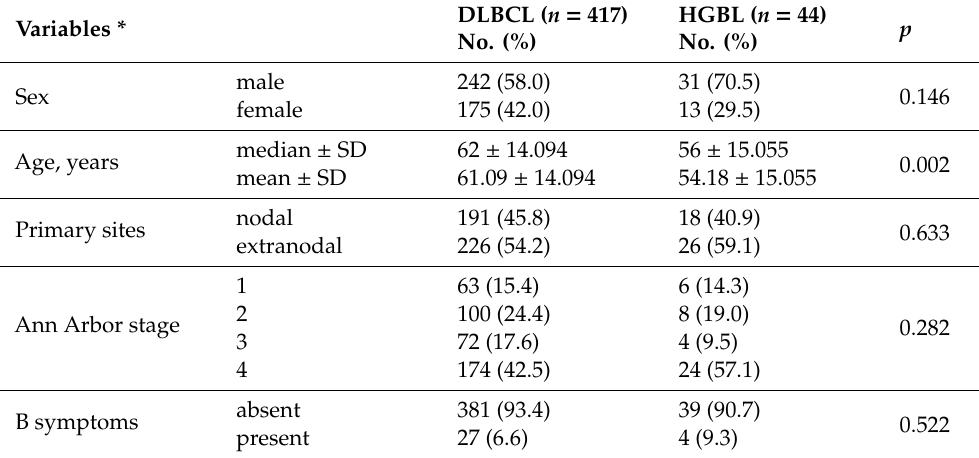
Figure 1. Immunophenotypic landscape of aggressive B-cell lymphoma. Stratification of aggressive B-cell lymphoma patients, including diffuse large B-cell lymphoma (DLBCL) and high-grade B-cell lymphoma (HGBL) based on MYC/BCL2 double expression (DE) status and cell-of-origin (COO). Table 1. Clinicopathological characteristics of patients with aggressive B-cell